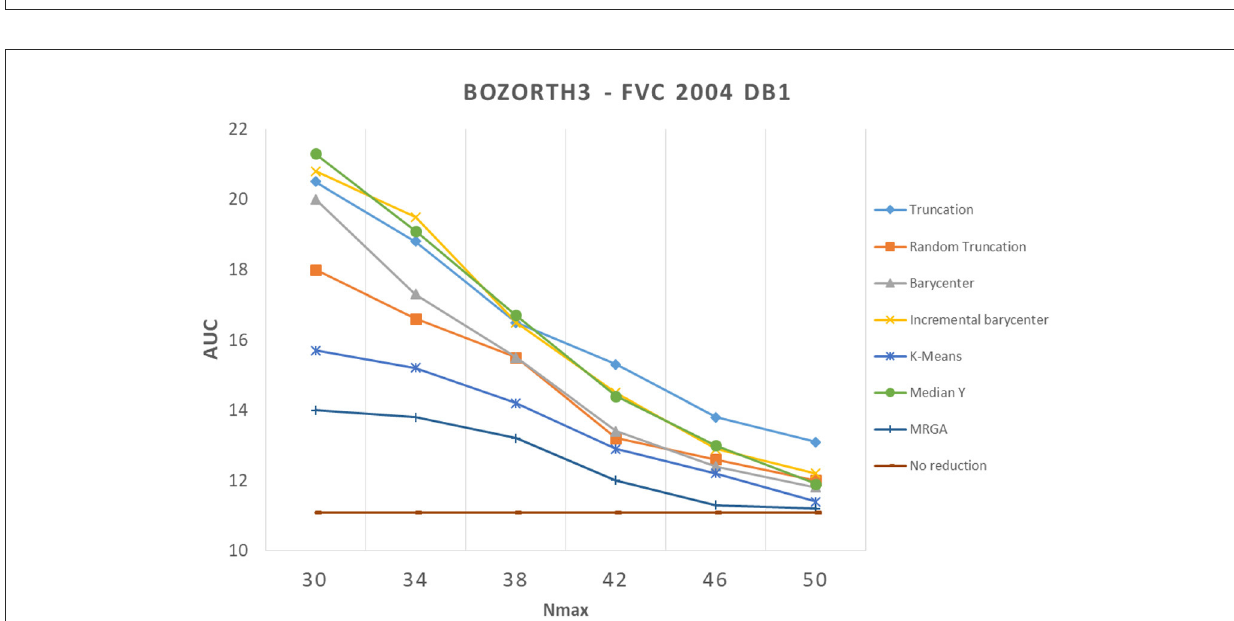
FIGURE6 Comparison of template reduction methods on the FVC 2004 DB1 with the Bozorth3 matching